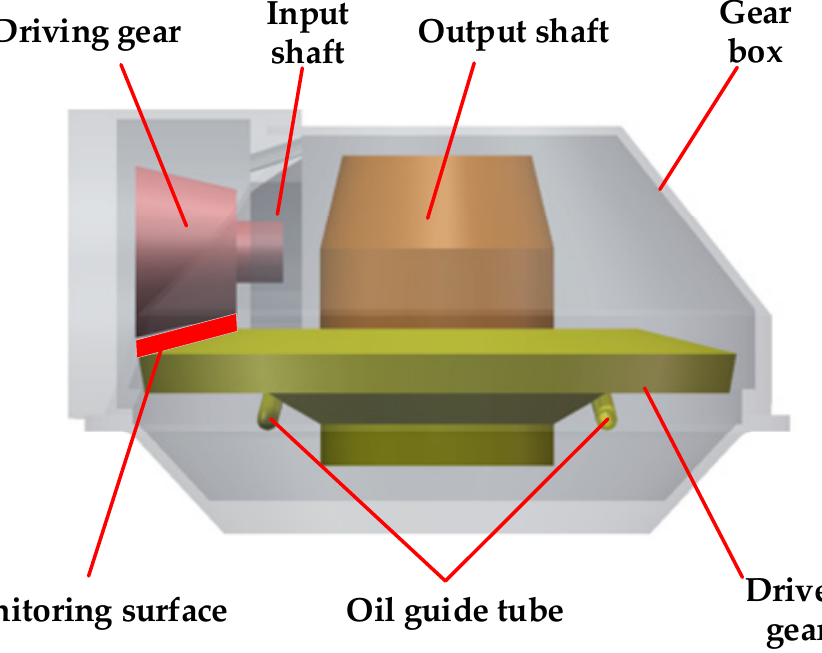
Figure 2. Simplified simulation model of the main gearbox.